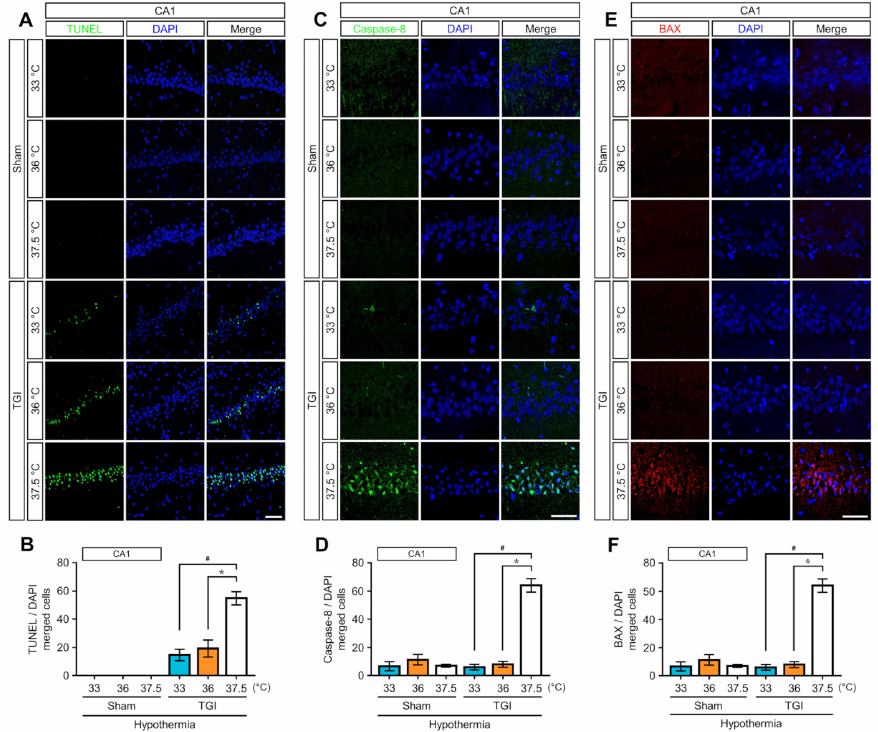
Figure 2. TTM suppresses apoptotic cell death 72 h after TGI. ( A ) Representative histological images display the number of TUNEL-positive cells in the cornus ammonis 1 of the sham or the hippocampus and in TGI. There were no differences in the number of TUNEL-positive cells in each sham group. TGI at a normal temperature at 37.5 ◦ C resulted in an increase in the number of these cells at 72 h. TGI-TTM at 33 ◦ C and 36 ◦ C significantly decreased TUNEL-positive cells compared to TGI at normal temperature at 37.5 ◦ C. Scale bar = 50 µ m. ( B ) Representative bar graphs show the number of TUNEL-positive cells in the sham and TGI groups (one way-ANOVA, multiple comparison following Bonferroni adjustment. Sham + 33 ◦ C, n = 5; Sham + 36 ◦ C, n = 5; Sham + 37.5 ◦ C, n = 5; TGI + 33 ◦ C, n = 8; TGI + 36 ◦ C, n = 5; TGI + 37.5, n = 8. * p and # p < 0.05). TTM at 33 ◦ C and 36 ◦ C reduces apoptosis-associated caspase-8 and Bcl-2-associated protein (BAX) expression at 72 h after TGI. The expression of apoptotic cell death-related caspase-8 and pro-apoptotic member, BAX, was suppressed by TTM at 33 ◦ C and 36 ◦ C after TGI. ( C ) In the sham groups, there were no differences in caspase-8 expression. TGI-normal temperature (NT) at 37.5 ◦ C upregulated the expression of caspase-8 within the hippocampal cornus ammonis 1 region. TTM at 33 ◦ C and 36 ◦ C significantly suppressed caspase- 8 expression. Scale bar = 50 µ m. ( E ) The apoptosis-related substrate, BAX, was overexpressed in TGI-NT 37.5 ◦ C. In the sham groups, there were no differences in BAX expression. TGI-TTM at 33 ◦ C and 36 ◦ C significantly reduced BAX expression. Scale bar = 50 µ m. ( D ) Bar graph indicates the percentage of caspase-8 expression. Caspase-8 expression is greater in TGI-NT at 37.5 ◦ C than at 33 ◦ C and 36 ◦ C (one way-ANOVA, multiple comparison following Bonferroni adjustment. Sham + 33 ◦ C, n = 3; Sham + 36 ◦ C, n = 3; Sham + 37.5 ◦ C, n = 3; TGI + 33 ◦ C, n = 3; TGI + 36 ◦ C, n = 3; TGI + 37.5, n = 4. * p and # p < 0.05). ( F ) Graph shows that BAX expression decreased in both hypothermic paradigms (one way-ANOVA, multiple comparison following Bonferroni adjustment. Sham + 33 ◦ C, n = 3; Sham + 36 ◦ C, n = 3; Sham + 37.5 ◦ C, n = 3; TGI + 33 ◦ C, n = 3; TGI + 36 ◦ C, n = 3; TGI + 37.5, n = 4. * p and # p <